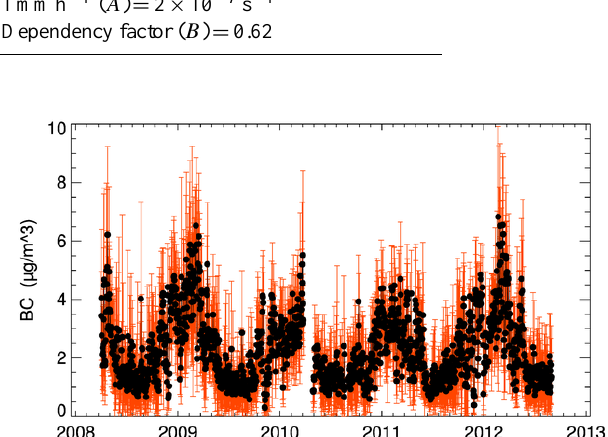
Figure 4. Daily mean BC concentration observed at Gadanki (black dots) and their ± 1 σ standard deviation (orange vertical